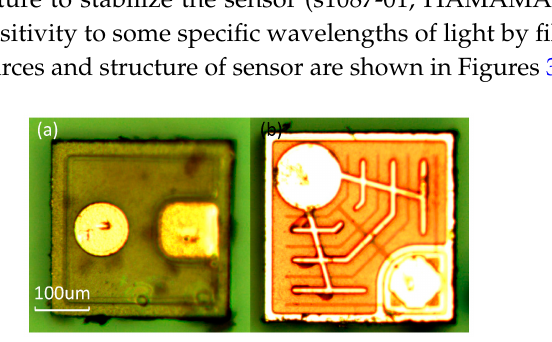
Figure 3. On-chip light sources. Panel ( a ) is the blue light source with a gold cathode (circular area) and anode (square area); Panel ( b ) is the red light source with a gold cathode (circular) and anode (square area).